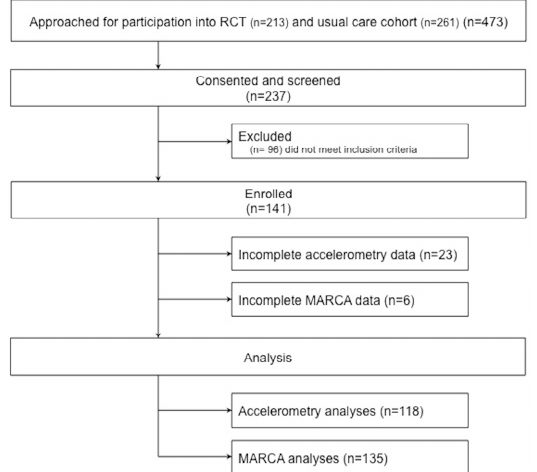
Figure 1. Participant flow—cross-sectional use of time study. RCT—randomised controlled trial, n—number, MARCA—Multimedia Activity Recall for Children and Adults.